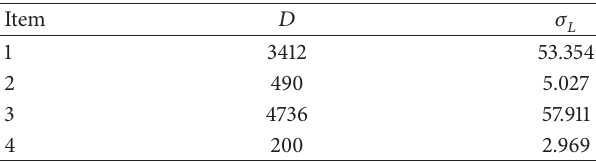
Table 1: The pharmaceutical data.